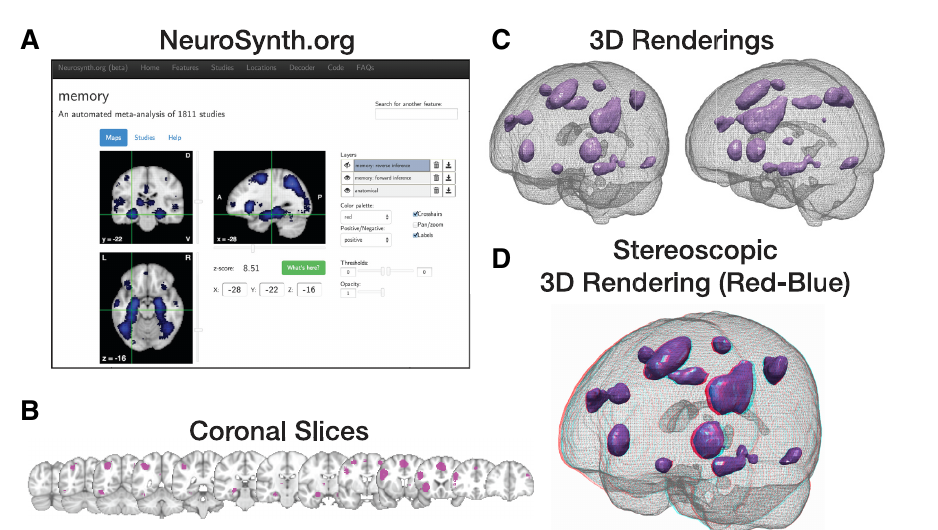
Figure 3. Images of the statistical map used in Procedure #1. ( a ) Obtaining the statistical map from NeuroSynth.org. ( b ) Coronal slices of the thresholded activation clusters. ( c ) 3D renderings of the clusters from two different perspectives. ( d ) Stereoscopic anaglyph 3D rendering of the first perspective shown in panel C, to be viewed using red-blue 3D